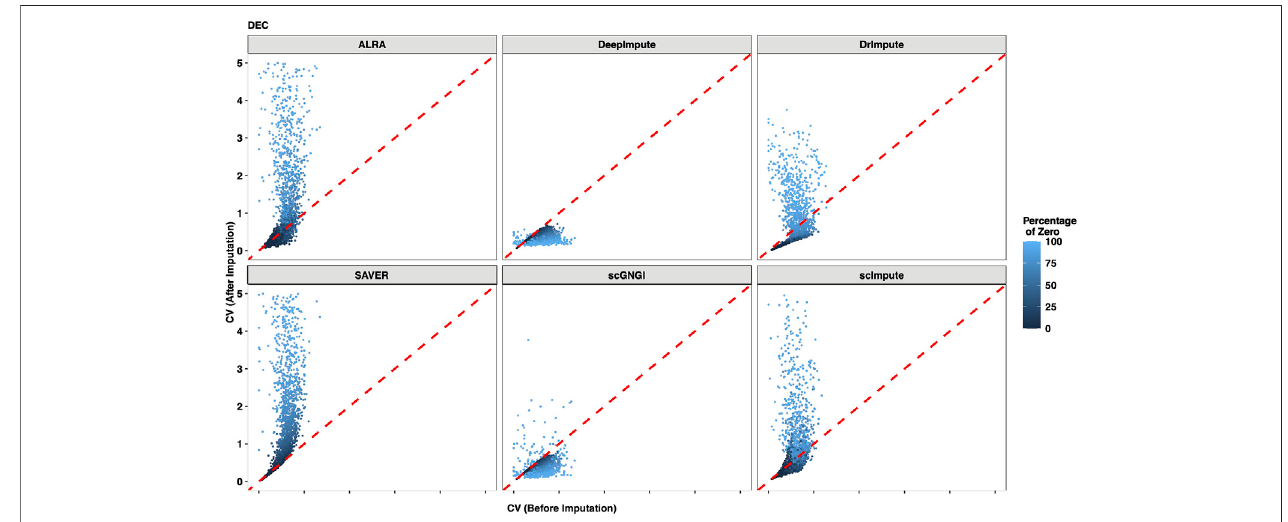
FIGURE 9 | Gene expression variation between the raw data and the imputed data for DEC cells in the Cell Type dataset. The coef fi cient of variation (CV) is computed for each gene in all DEC cells after imputation ( y -axis) by using different methods, and the x -axis represents the CV of non-zero cells before imputation. Each dot represents a gene, and the mean level of the non-zero values is distinguished by its